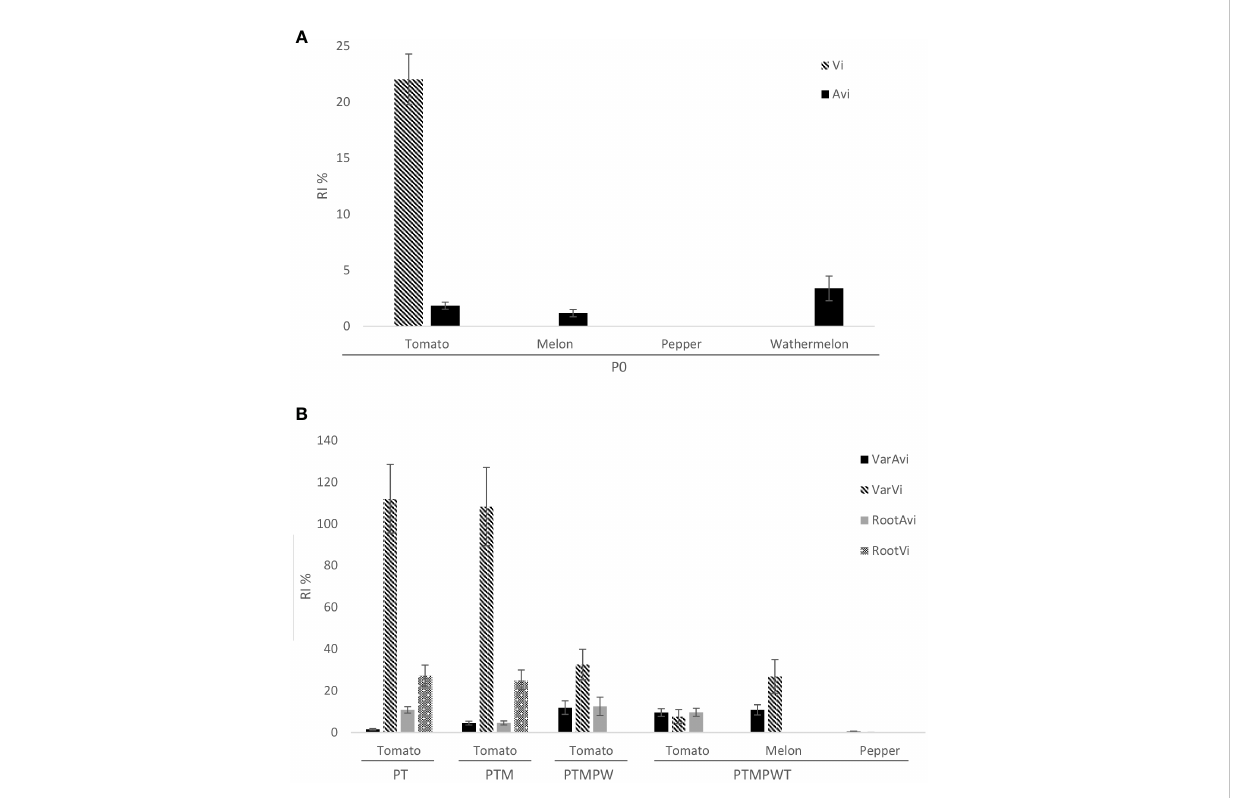
FIGURE 3 Reproduction Index (RI: percentage eggs plant -1 produced in resistant germplasm respect those produced in the susceptible germplasm) (A) of Mi1.2 avirulent (Avi) and virulent (Vi) Meloidogyne incognita populations obtained from soil before the rotation sequence (P 0 ) in resistant tomato cv. Monika, melon rootstock C. metuliferus , pepper rootstock ‘ Oscos ’ and watermelon rootstock C. amarus and (B) of the Mi1.2 avirulent (VarAvi and RootAvi) and partially virulent (VarVi and RootVi) subpopulation obtained from roots of each crop of the rotation scheme tomato (P T )- melon (P TM )- watermelon (P TMPW ) in resistant tomato cv. Monika, and from roots of the last tomato crop (P TMPWT ) in the melon rootstock C. metuliferus and pepper rootstock ‘ Oscos ’ too. The columns represent the mean and the bars represent the standard error of 15